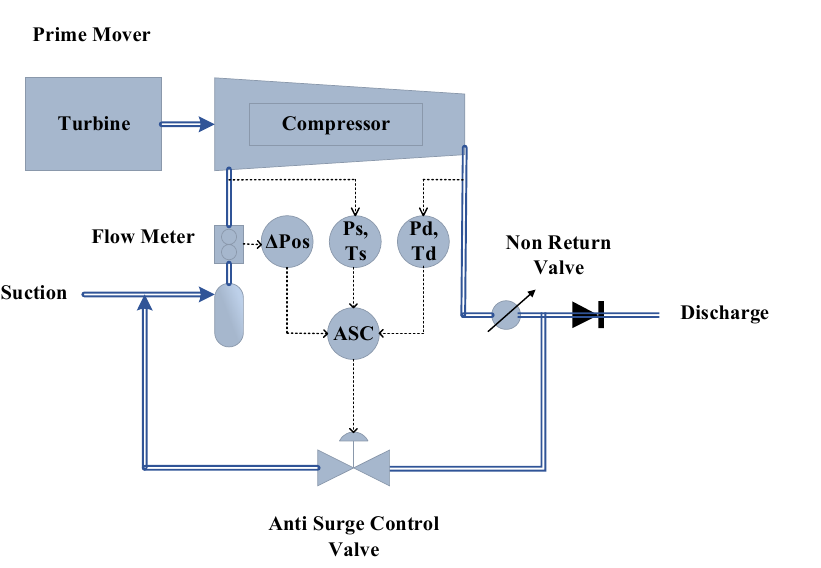
Figure 6. The anti-surge control [21].